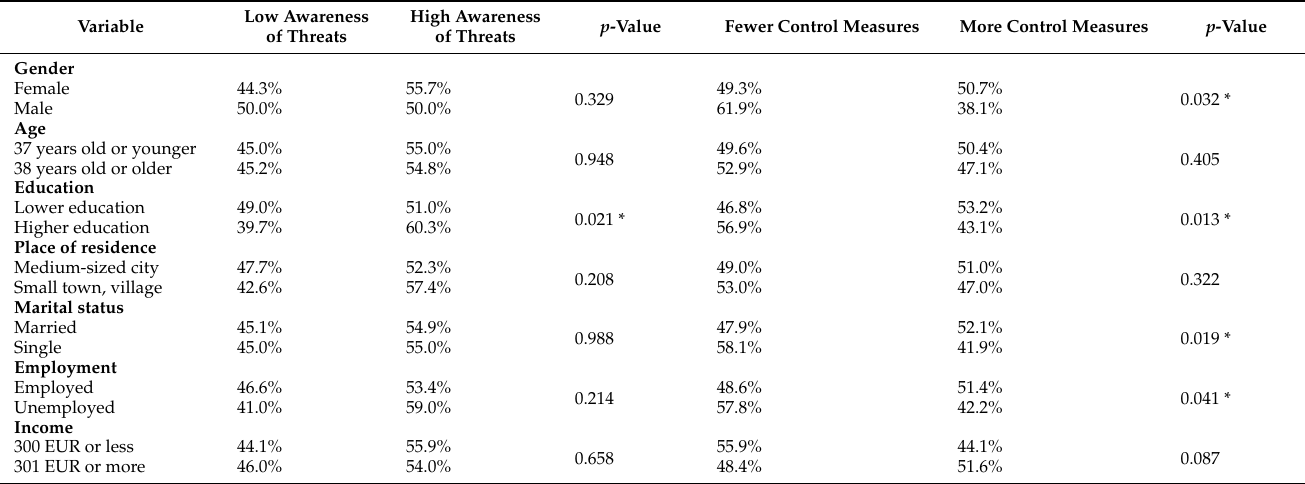
Table 4. Distribution of respondents by control measures taken, threat awareness, and sociodemo- graphic factors ( n =